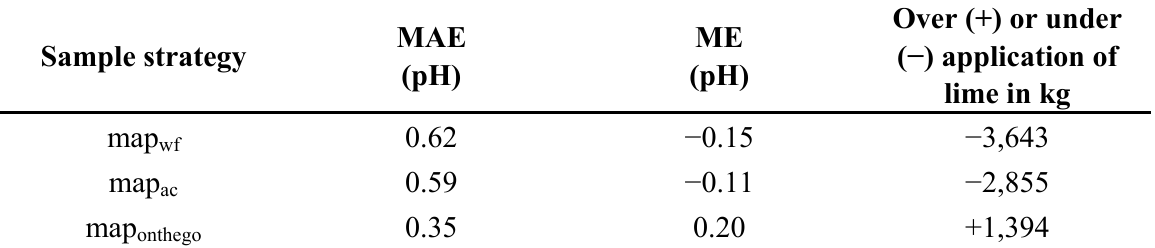
Table 4. Comparison of whole field sampling with on-the-go